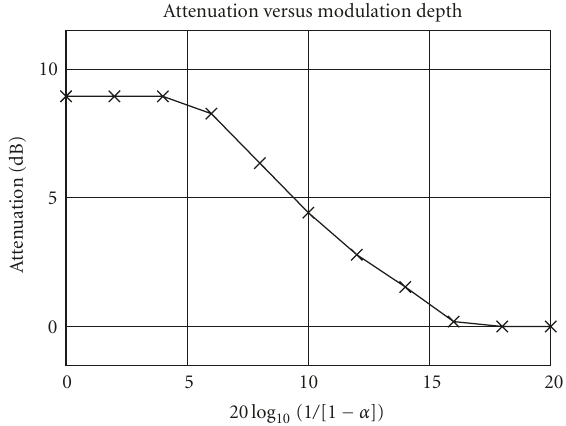
Figure 4: Measured dependency of noise reduction attenuation on modulation depth parameter 20 · log